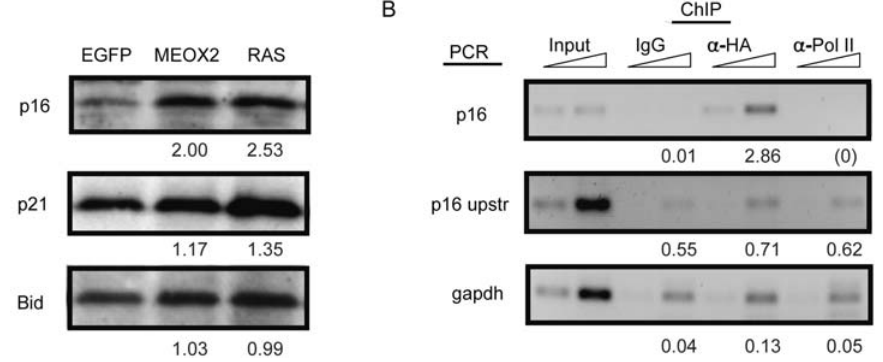
Figure 7. MEOX2 induces senescence through transcriptional activation of p16INK4a. (A) MEOX2 activates p16INK4a expression. Fibroblasts infected with retroviral constructs expressing the indicated cDNA (top) were harvested 9 days postinfection, and whole cell extracts assayed by western blot with the indicated antibodies (left). Bid serves as a loading control. Band intensities relative to the EGFP control are indicated. (B) MEOX2 binds to the p16INK4a promoter. Fibroblasts stably infected with a retroviral construct expressing hemagglutinin (HA)-tagged MEOX2 were harvested 15 days postinfection and subjected to chromatin immunoprecipitation with HA, PolII, or preimmune IgG antibodies. The resulting chromatin was assayed for enrichment of the indicated sequences by semiquantitative PCR with increasing cycle numbers. Band intensities relative to the input are indicated for the higher PCR cycle number; (0) indicates values at or below background intensity. The p16 primers amplified a fragment located 970 to 621 bp upstream of the INK4a ATG site, which is selectively enriched by MEOX2-HA immunoprecipitation. GAPDH and an amplicon located 5 kilobases upstream of the INK4a coding sequence (‘‘p16 upstr’’) serve as controls.